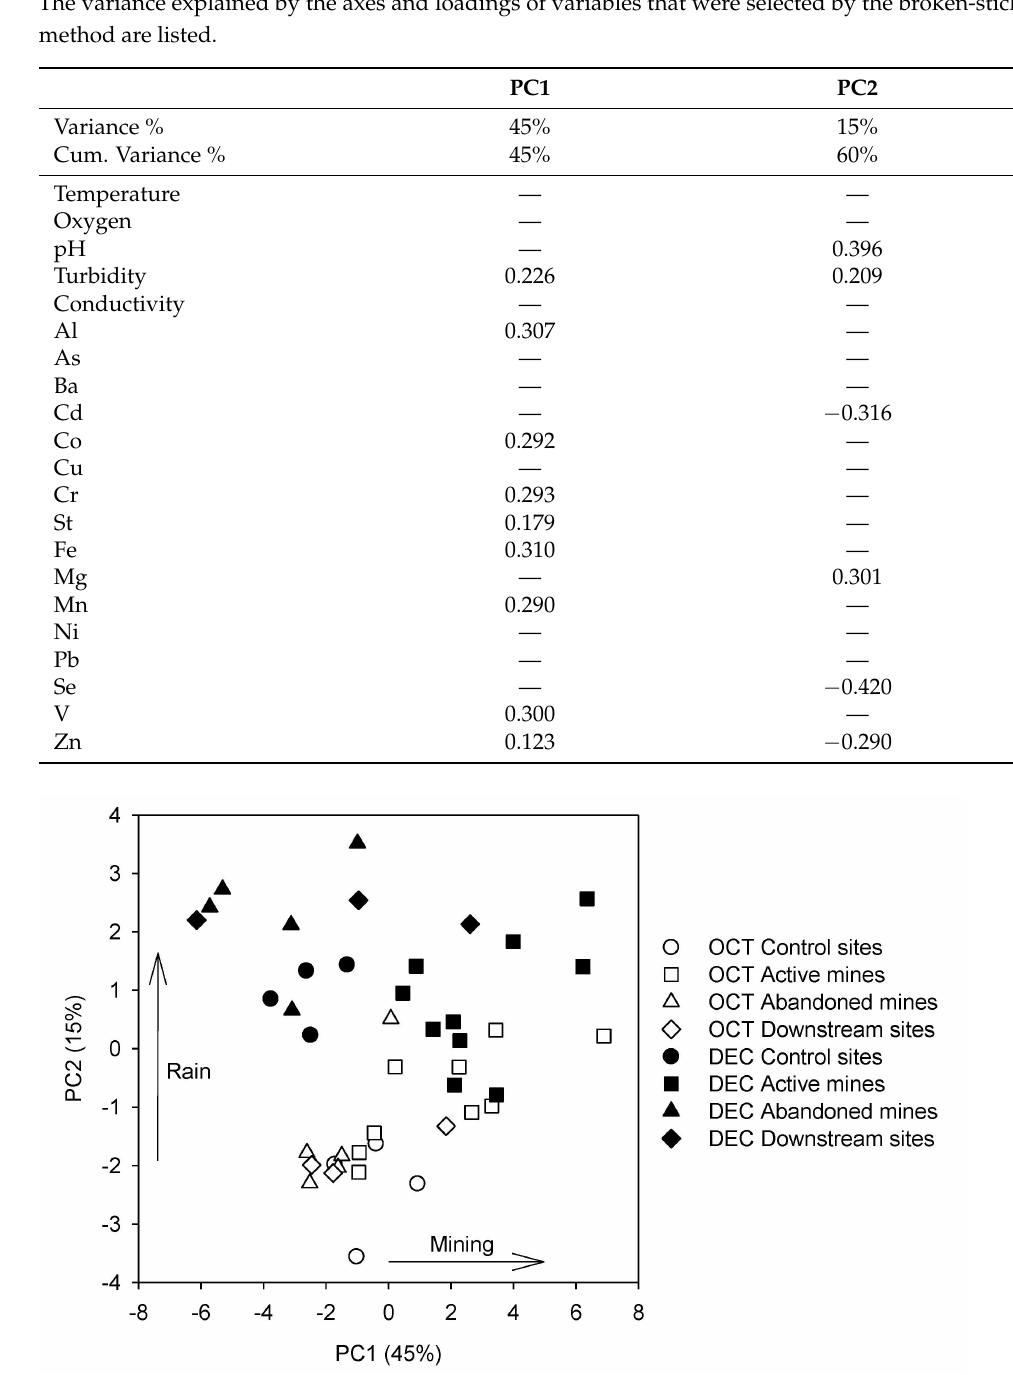
Figure 4. Results of the PCA on the physical and chemical variables and heavy metal concentrations at the study sites (OCT, October samples; DEC, December samples, CS, control sites; AcM, active mines; AbM, abandoned mines; DS, downstream